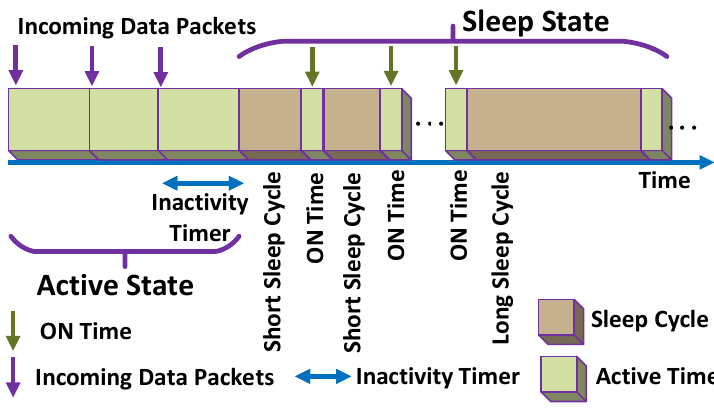
Figure 2. LTE-DRX timing